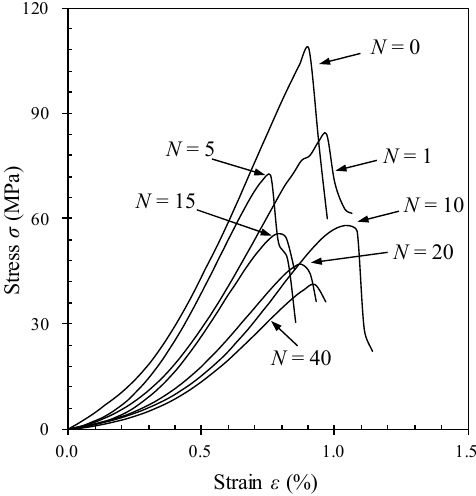
Figure 7. Stress-strain curves of sandstone specimens after wetting-drying cycles.